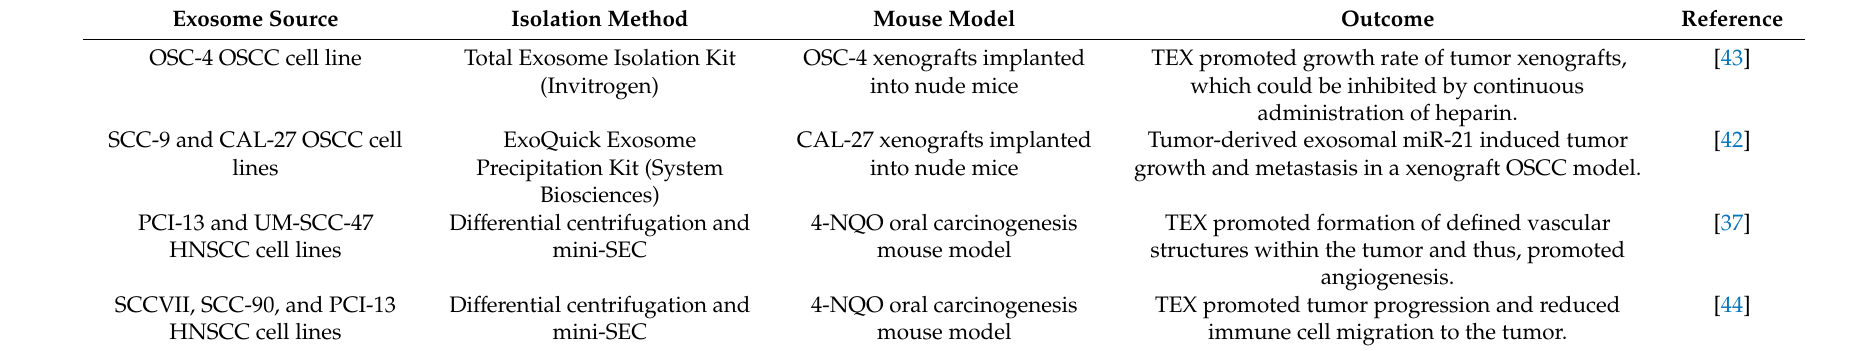
Table 2. E ff ects of exosomes on tumor progression and immune suppression: in vivo